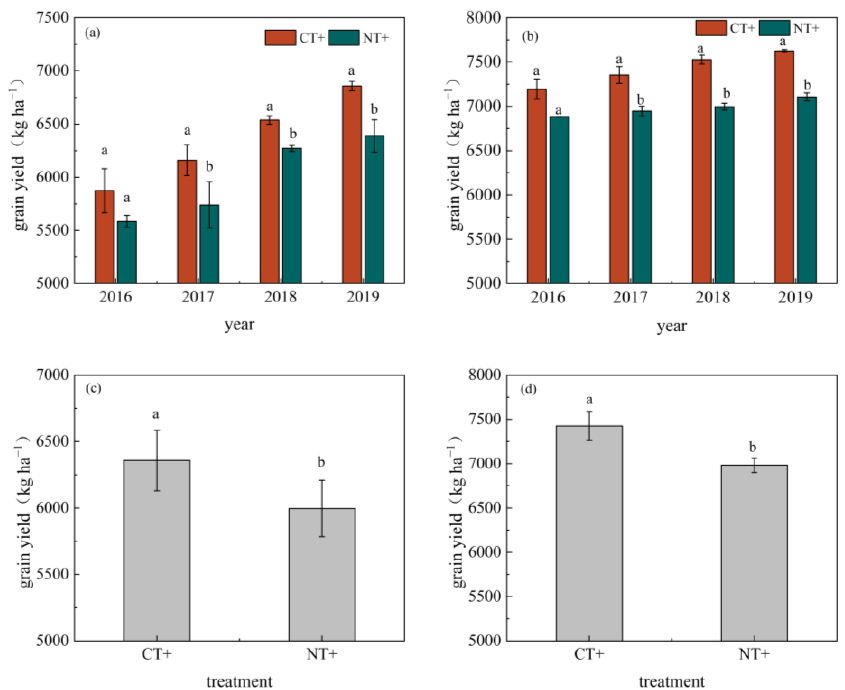
Figure 4. Grain yield of wheat from 2016 to 2019 at ( a ) Wudi and ( b ) Yucheng; four-year average grain yield at ( c ) Wudi and ( d ) Yucheng sites. CT+ is crop residue incorporated into the soil with plough tillage, NT+ is crop residue mulching soil with no-till. The small letters indicate the significant differences across treatments at p < 0.05 level.